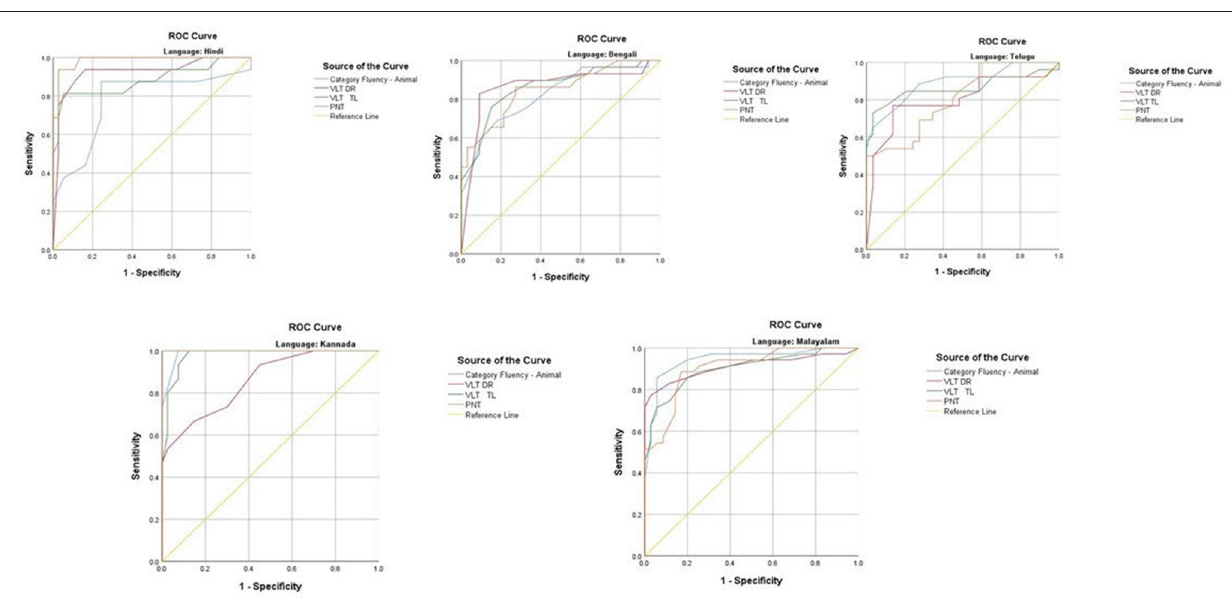
of all major cognitive domains in the ICMR-NCTB is reflected in the relatively high diagnostic sensitivity and specificity of majority of the cognitive domains in this dementia cohort consisting of multiple subtypes. While the study has established successful discriminability between dementia and controls across all tests, the most efficacious combination of measures discriminating healthy controls from patients with dementia is yet to be